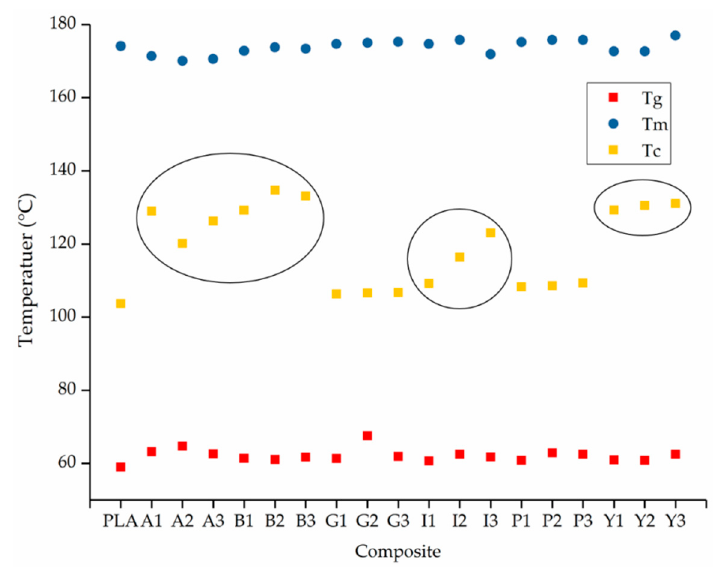
Figure 5. The T g , T c and T m of PLA and its composites. The three rings indicate the relationship between T m and weight percentage for alizarin, indigo, and the blue and yellow pigments. (The composites having a di ff erent T C have been circled for easy